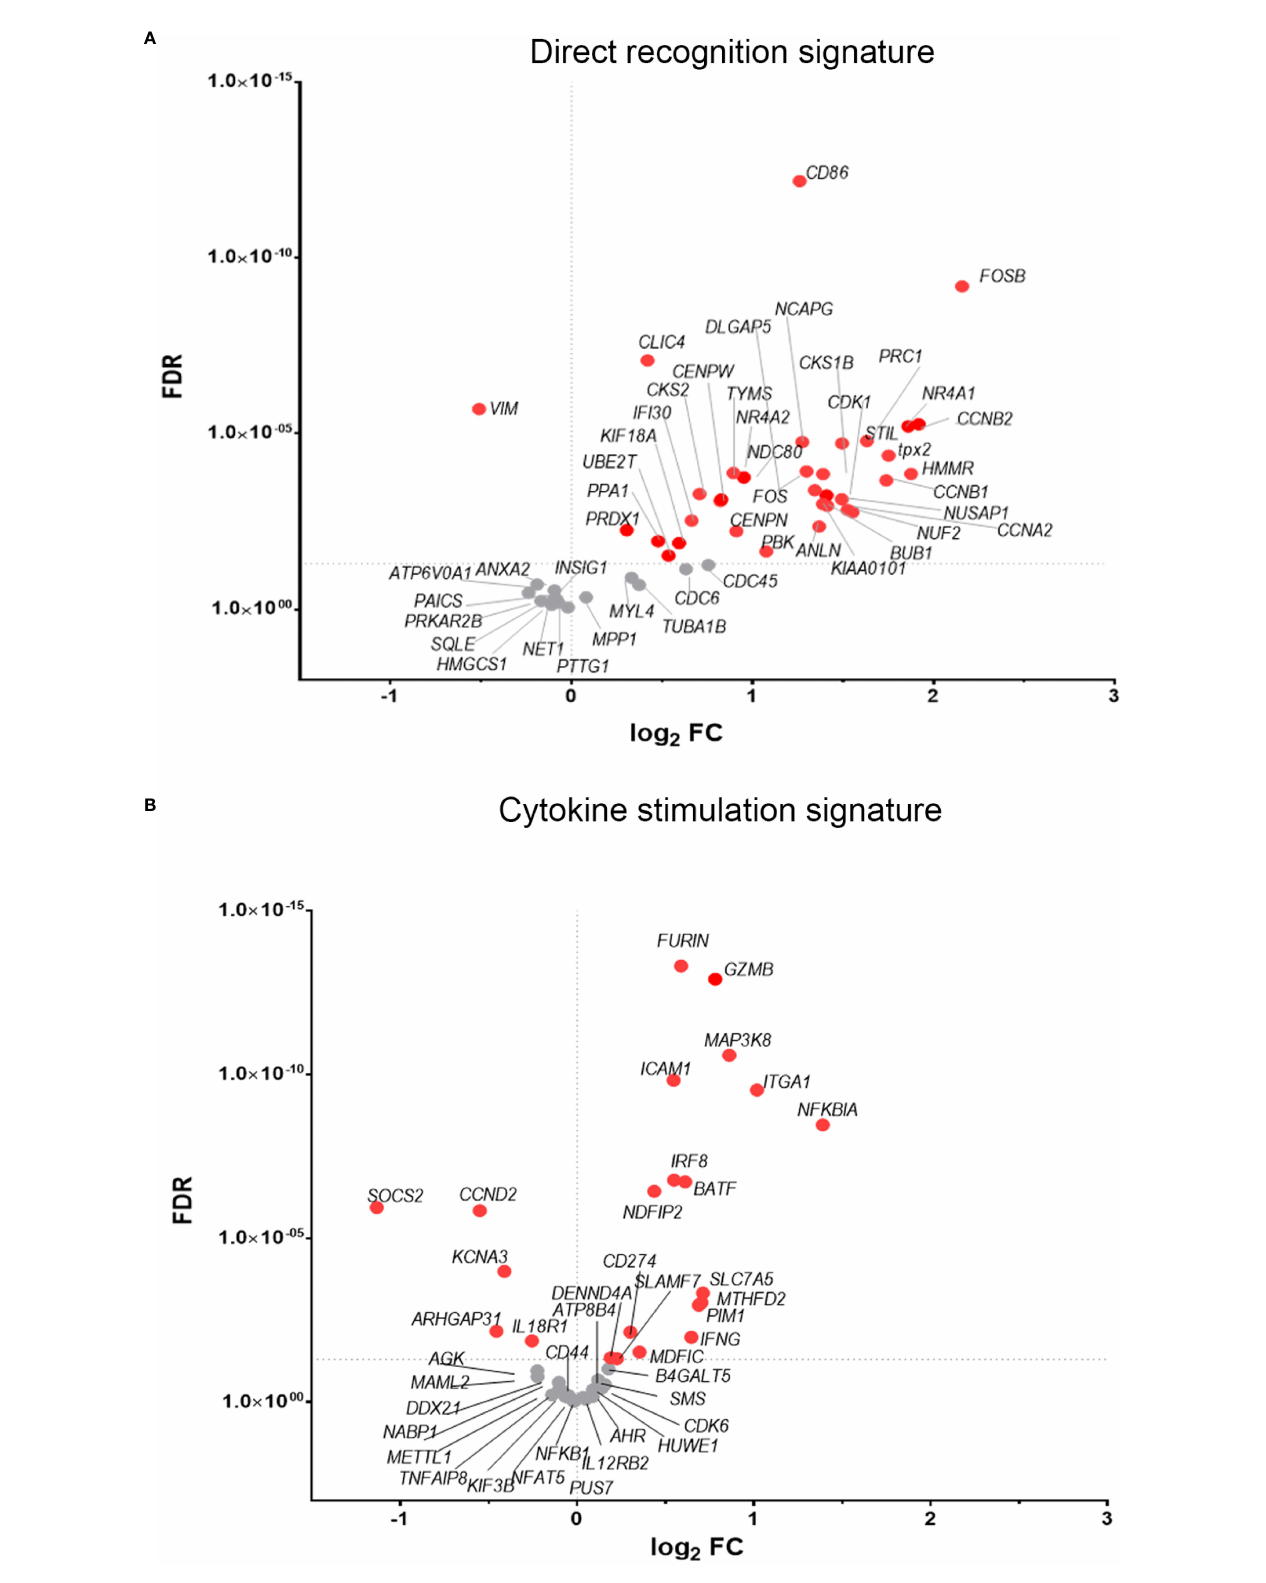
FIGURE 4 NK cells exhibit transcriptional signatures consistent with direct cell recognition and cytokine stimulation. The differential expression pro fi le (VACV vs mock) of transcripts detected in RNA-seq that are indicative of (A) direct recognition of infected cells, or (B) cytokine stimulation are shown. Each transcript is represented by a dot, its FC (WT vs mock) is shown on the Y-axis, and statistical signi fi cance of the FC (FDR) is shown on the X-axis. Comparator dataset reference GSE110446. Red indicates statistical signi fi cance